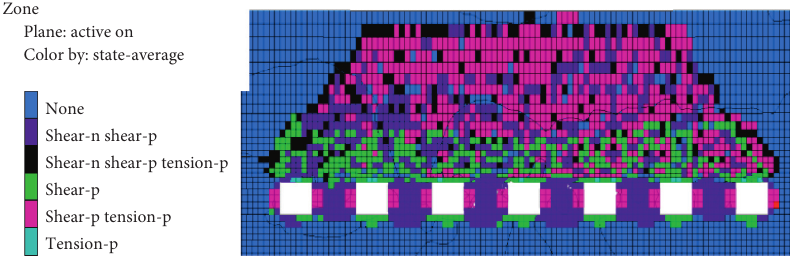
Figure 7: The plastic zone distribution in the surrounding rock.